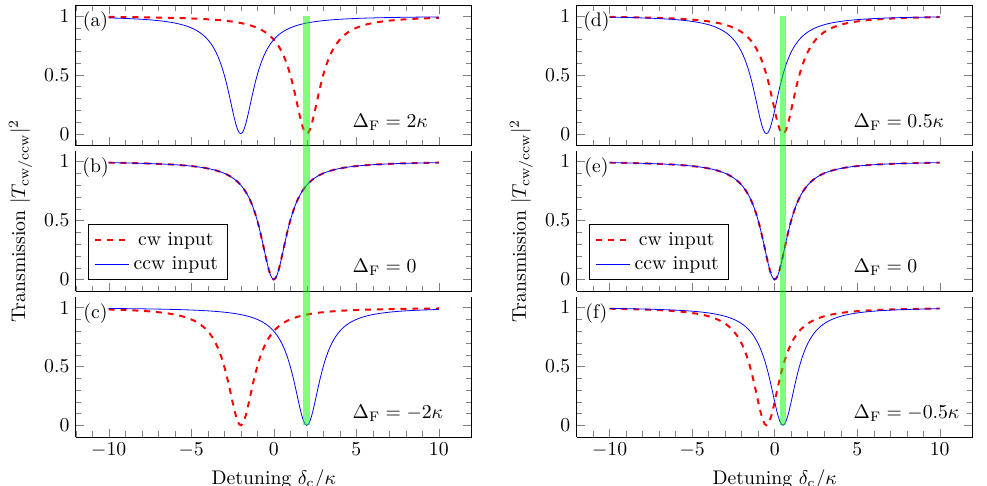
2 of the optical input field versus the T cw,ccw | |